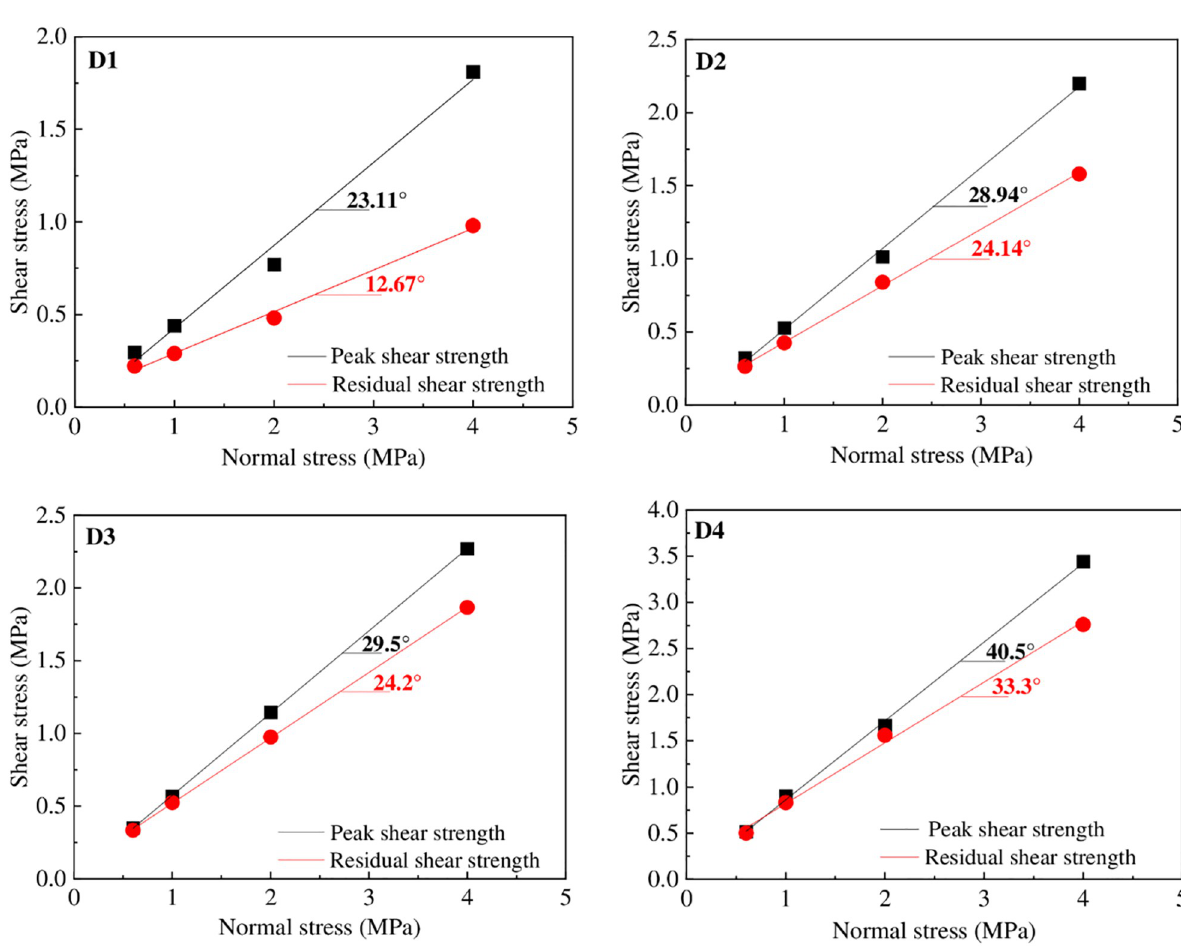
Fig 12. Peak and residual friction angles from plots of shear stress versus normal